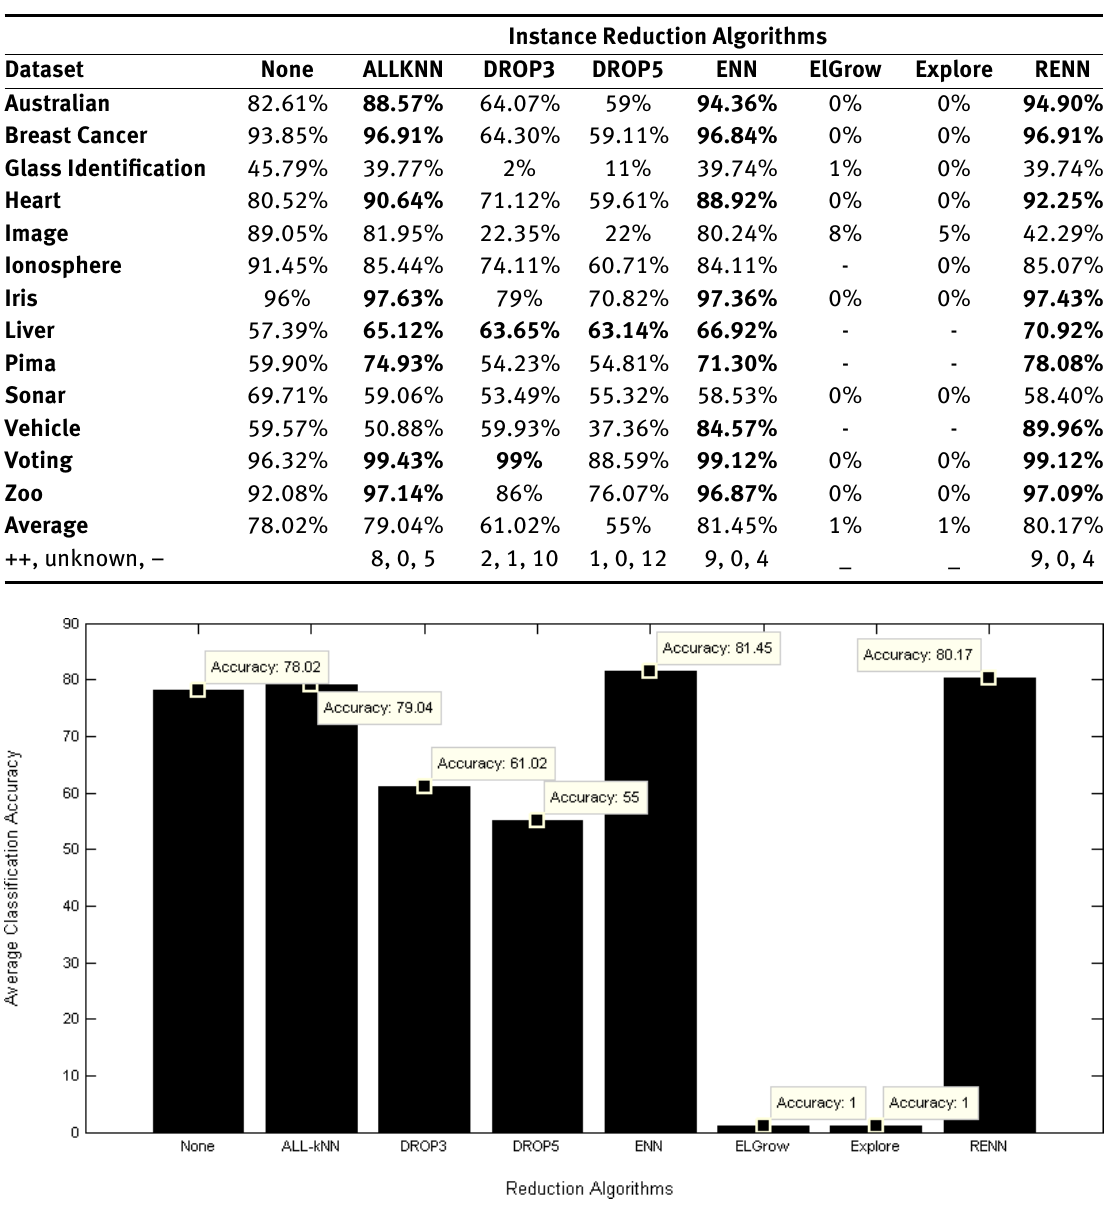
Figure 2: Average Classification Accuracy for Unpruned Trees With 0% Noise Ratio